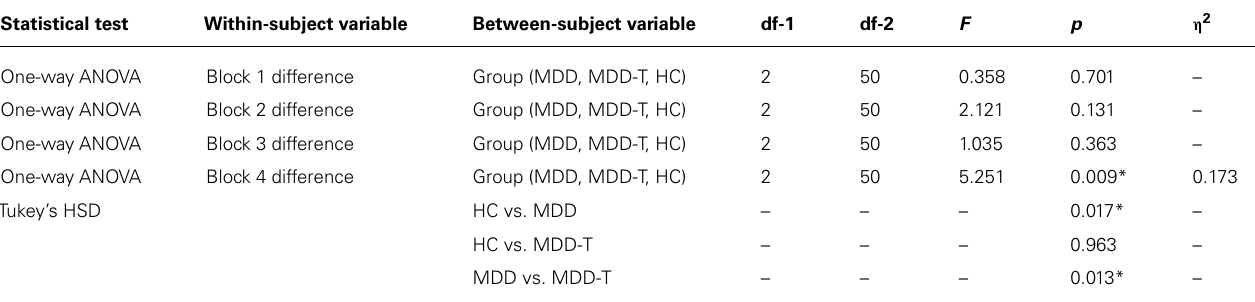
Table 3 | Summary of the post hoc one-wayANOVA andTukey’s HSD post hoc analyses on each block of mean difference between percentage correct responses in reward and punishment trials to investigate the interaction between block and group, with group as the between subject variable and the mean difference between percentage correct responses in reward and punishment trials as the dependent